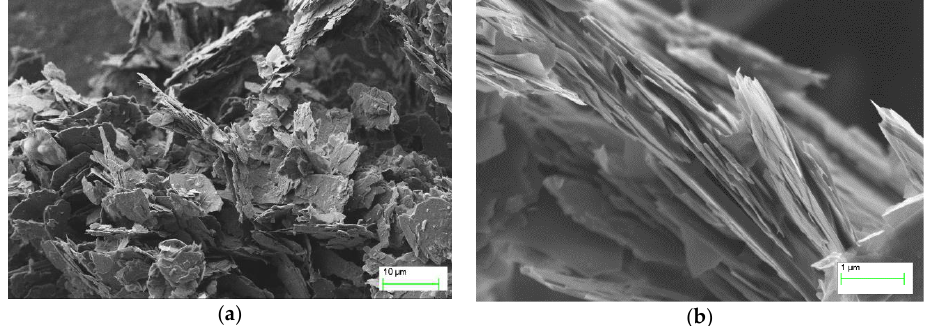
Figure 1. Scanning electron microscope pictures of graphene nanoplatelets used in the inks.